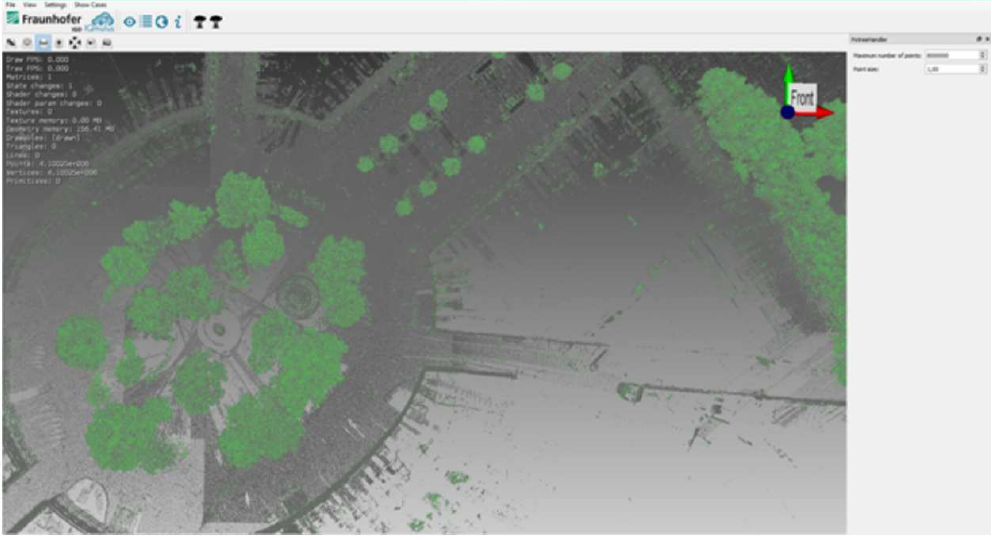
Figure 8. View on the Toulouse data set during asynchronous refinement. Note the difference in point density between the left and right parts of the